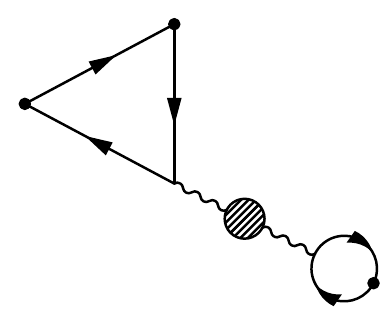
Figure 1 . Diagram contributing to the three point function h j 1 j s 0 j s i